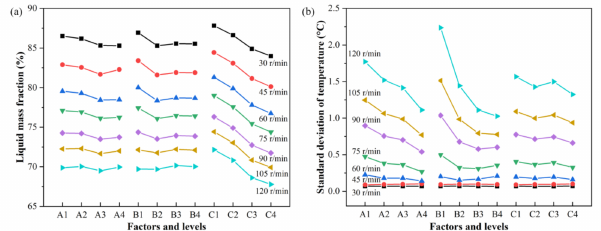
Figure 10. Variation curve of LMF ( a ) and T SD ( b ) with factors and levels at different screw